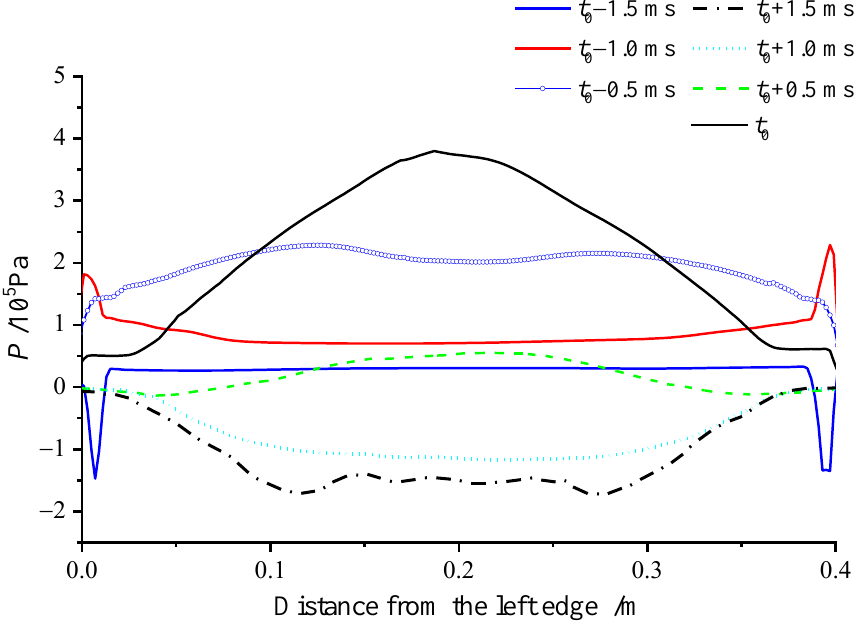
Figure 11. Distribution of the pressure along the bottom.